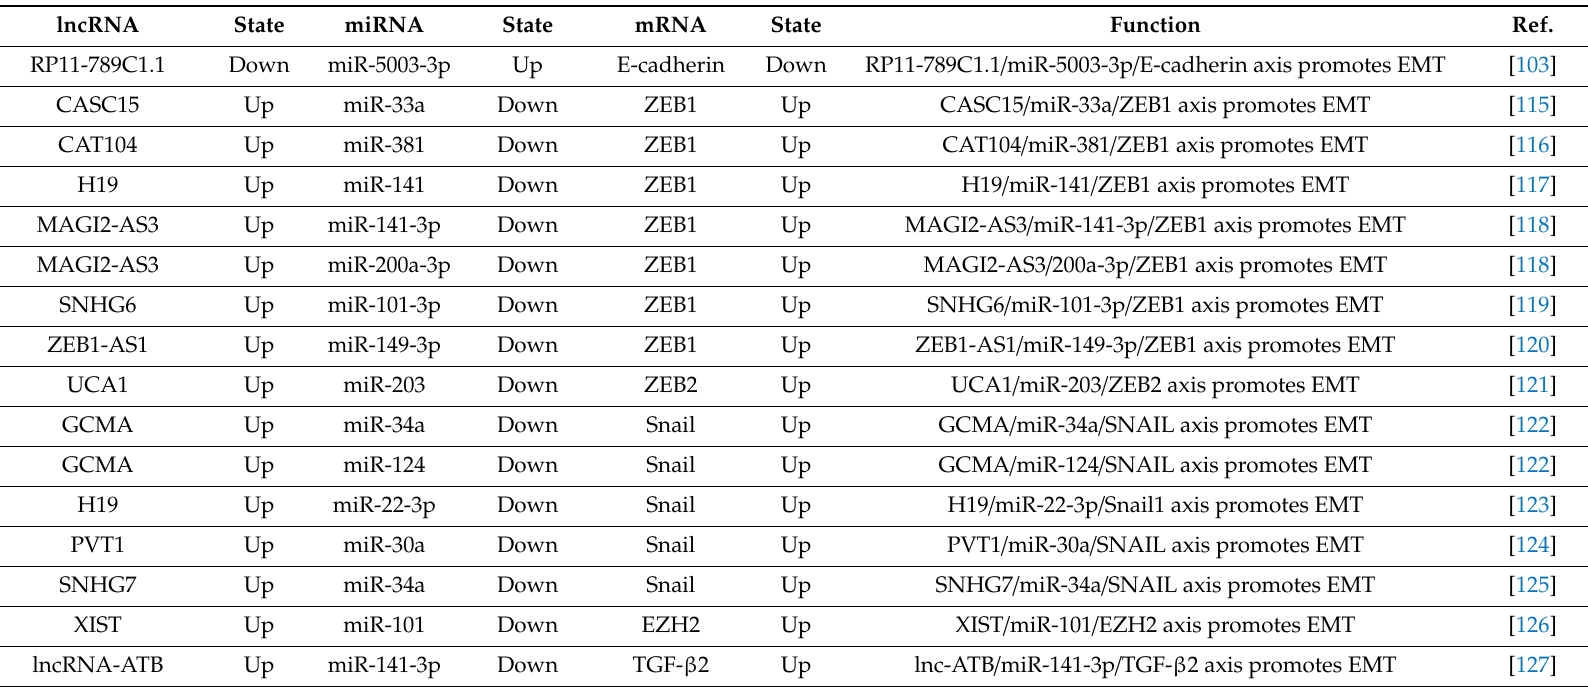
Table 3. Summary of all ceRNAs interactions and their roles in the EMT process associated with di ff use-type gastric cancer. lncRNA State miRNA State mRNA State Function Ref. RP11-789C1.1